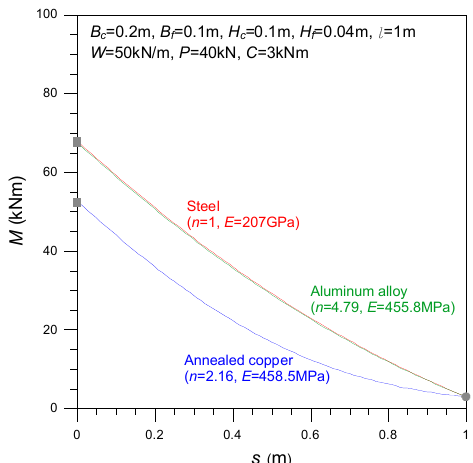
Figure 8. Bending-moment diagrams for steel, aluminum alloy, and annealed copper beams. Appl. Sci. 2019 , 9 , x FOR PEER REVIEW 11 of 12